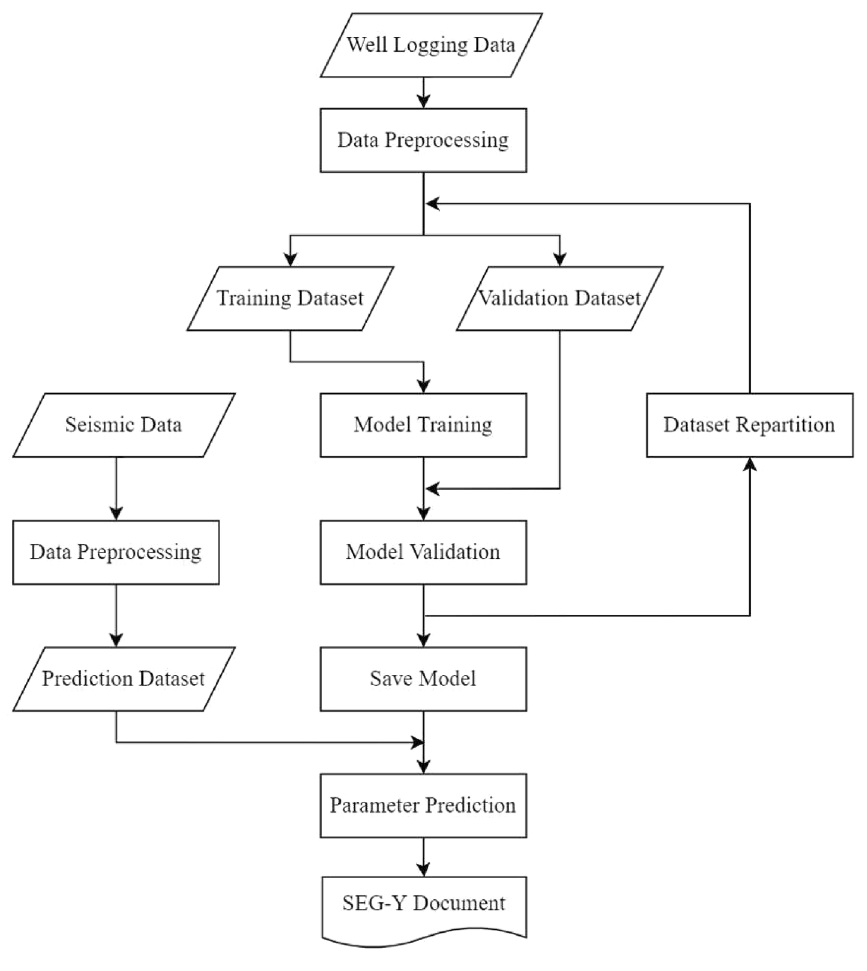
Figure 5. Prediction